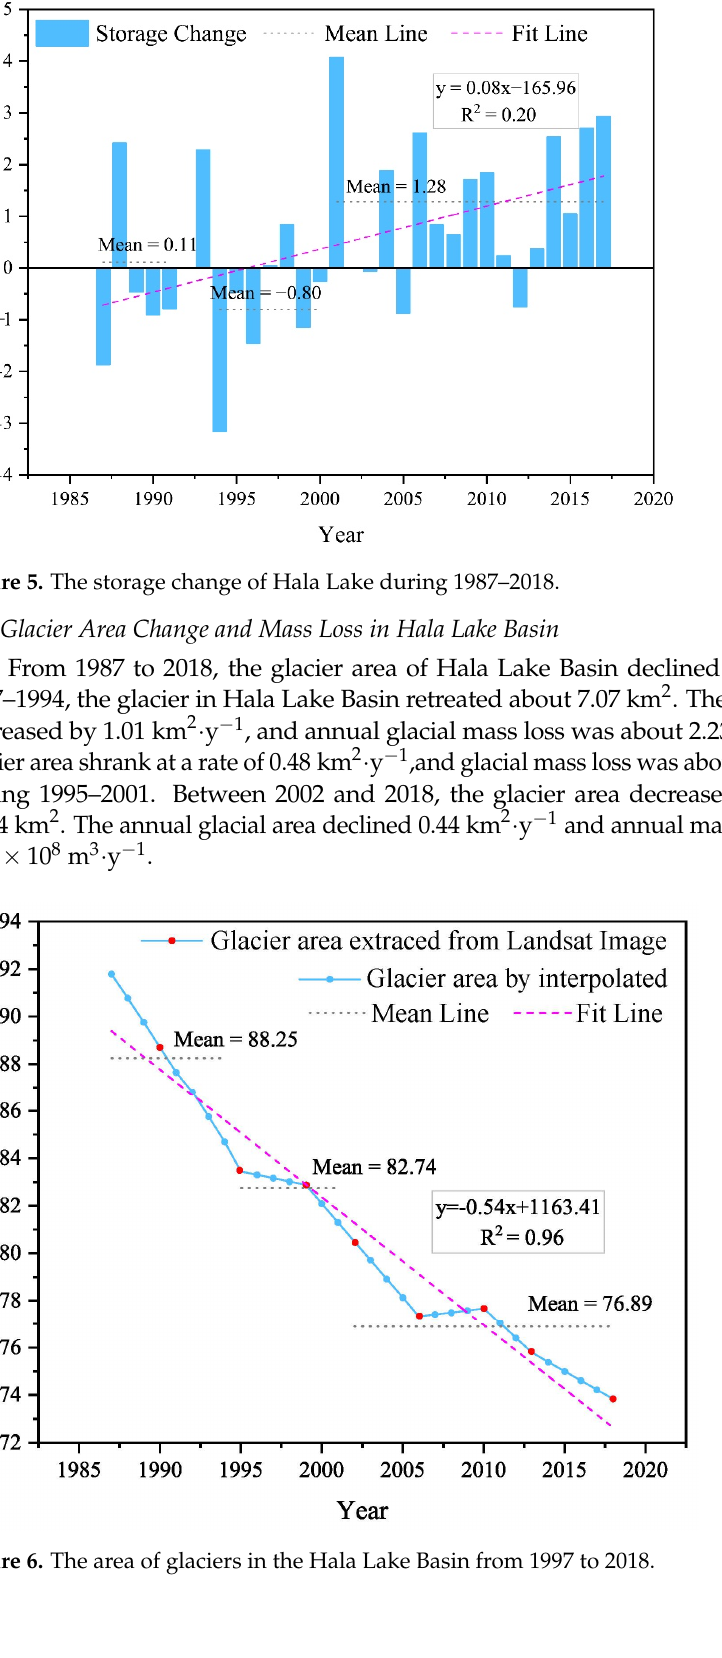
Figure 4. The water area and level of Hala Lake during 1987–2018.